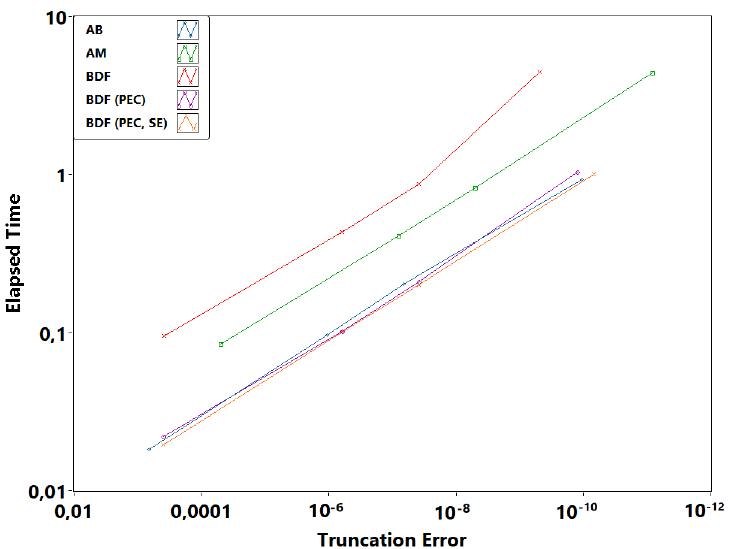
Figure 9. Comparison of the error versus elapsed time for the family of investigated methods on the van der Pol oscillator